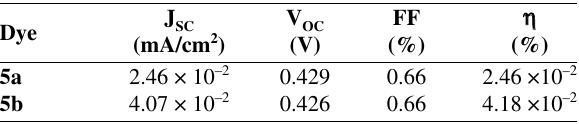
Table 3. The photovoltaic parameters of the synthesized dyes 5a and 5b J V FF ηη SC OC Dye (mA/cm 2 ) (V) (%) (%)